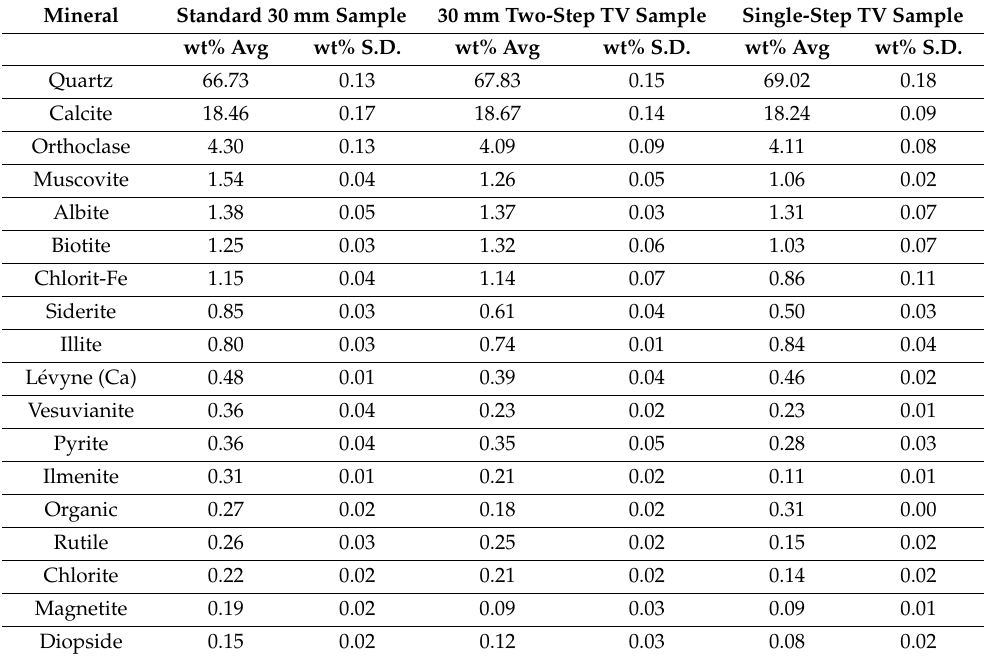
Table 1. Modal mineralogy of sample 2 via SEM-MLA analysis (XBSE; extended backscattered electron mode) with three different methods of sample preparation (n = 3 replicates for each analysis).